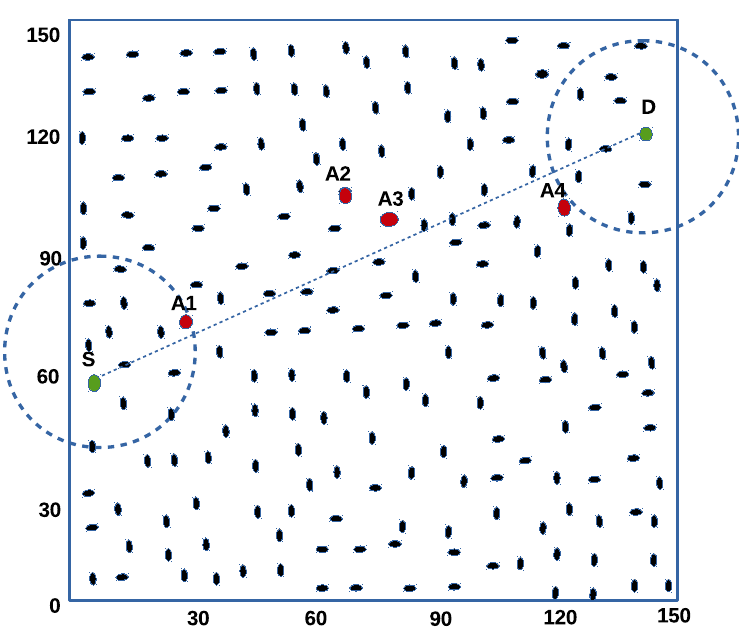
Figure 5. Strategic placement of malicious nodes